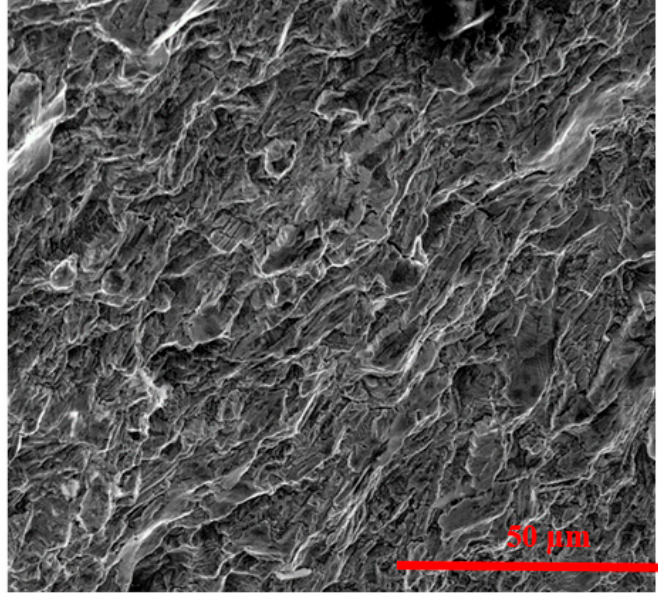
Figure 9. SEM image taken at area of interest 1. This image contains examples of quasi-cleavages and facets.